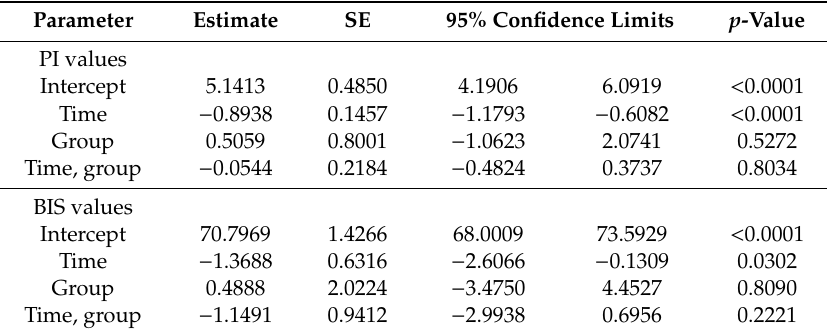
Table 3. Analysis of generalized estimating equations.